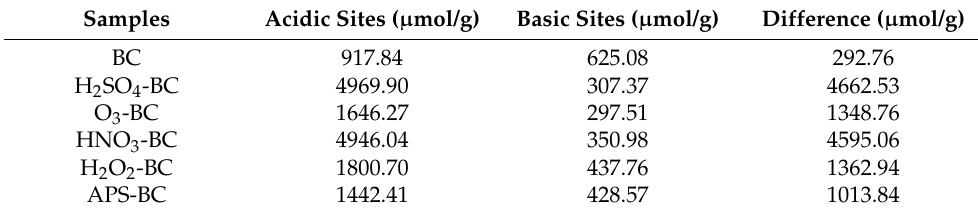
Table 3. Concentration of acidic and basic sites in biochar